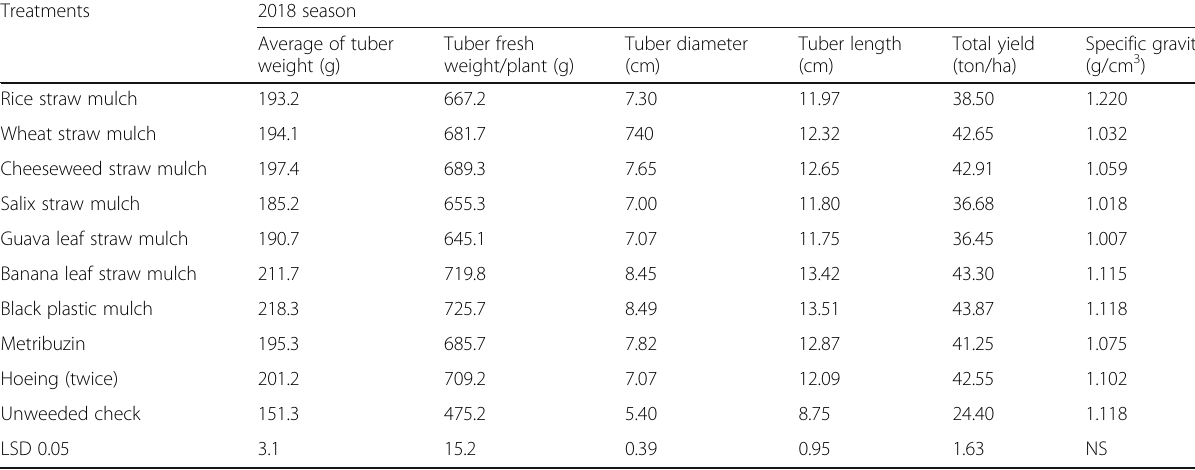
Table 5 Effect of different weed control treatments on yield traits of potato plants during 2018 season